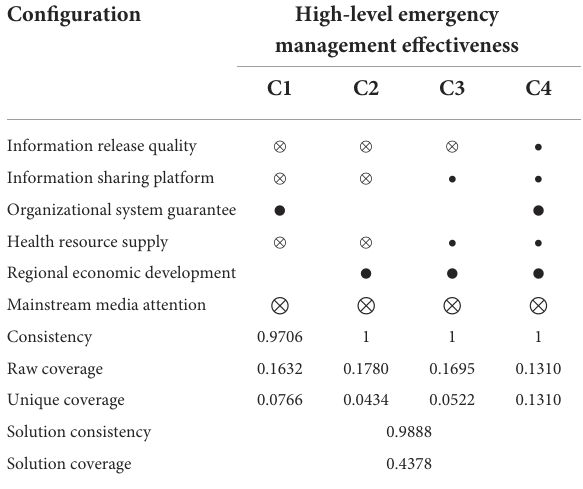
TABLE 5 Robustness test results for excluding sample